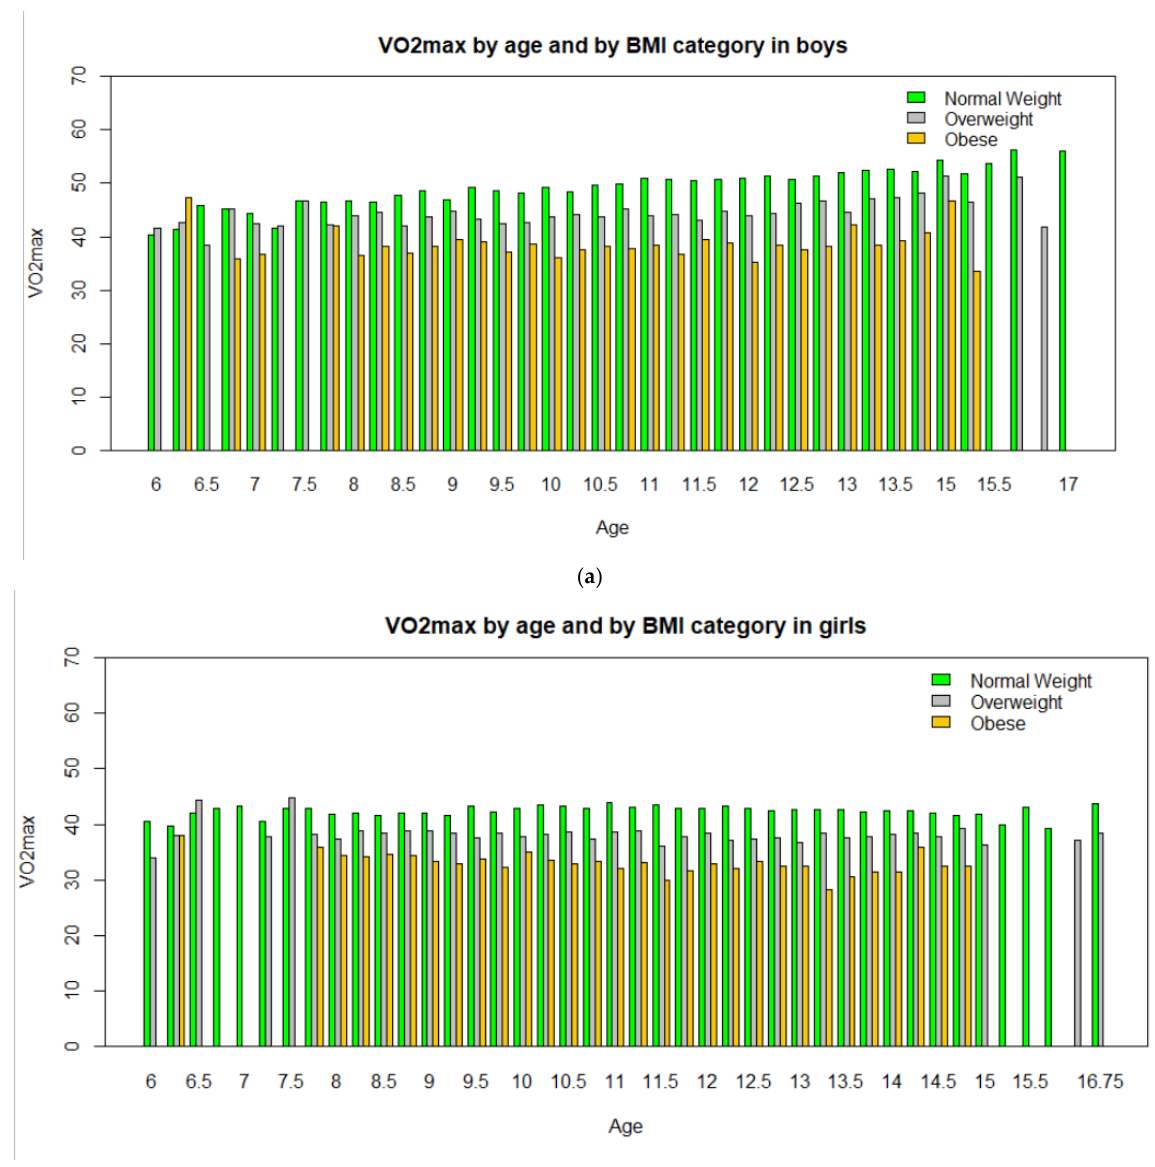
Figure 3. VO 2 max by age and BMI category in boys ( a ) and girls ( b ). weight (a) girls and (b) boys and height for (c) girls and (d) boys, indicating a negative relationship for the weight variable and a positive relationship for the height variable. In addition, the figures indicate that the assumption of a linear relationship between these variables may be supported by the